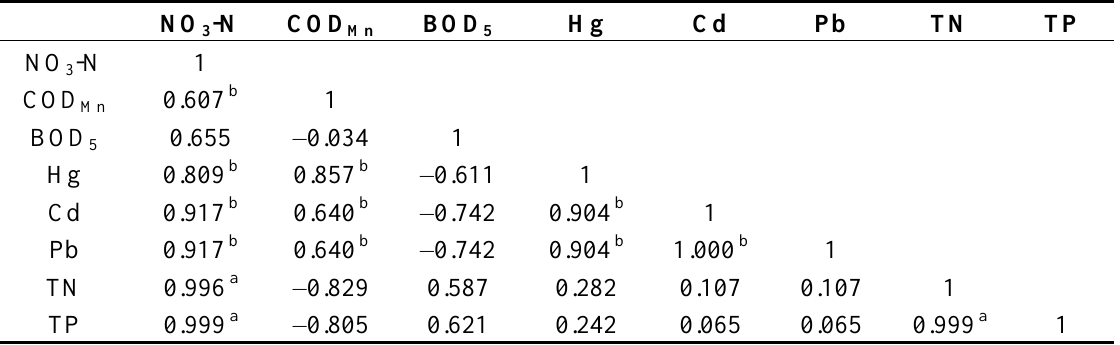
Table 2. Bivariate correlation coefficients of water quality